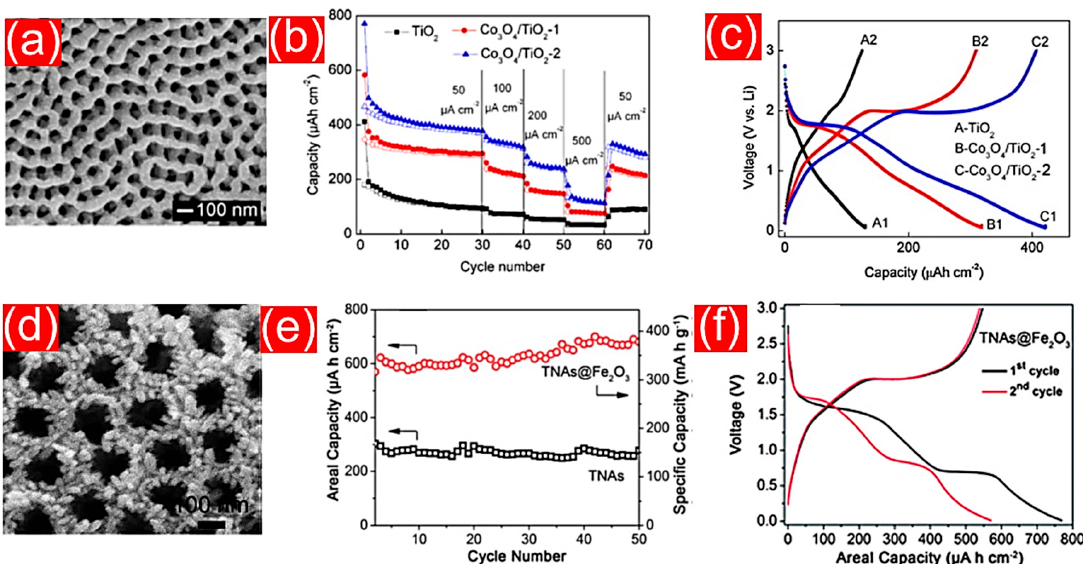
Figure 14. ( a ) SEM images of Co 3 O 4 -coated TiO 2 nanotubes obtained at photodeposition time of 4 h and ( b ) their areal capacities measured at different current densities, ( c ) voltage profile curves of bare TiO 2 (A), as-synthesized Co 3 O 4 /TiO 2 -1 with Co 3 O 4 loading of 0.12 mg cm − 2 (B) and Co 3 O 4 /TiO 2 -2 with Co 3 O 4 loading of 0.25 mg cm − 2 (C) electrodes as anodes in the 10th cycle adapted from ref. [163]. ( d ) SEM image of Fe 2 O 3 nanorod onTiO 2 . ( e ) Cycling performances of Fe 2 O 3 @TiO 2 in comparison with bare TiO 2 and ( f ) their voltage profile in the 1st and 2nd cycles. Adapted with permission from ref. [167].